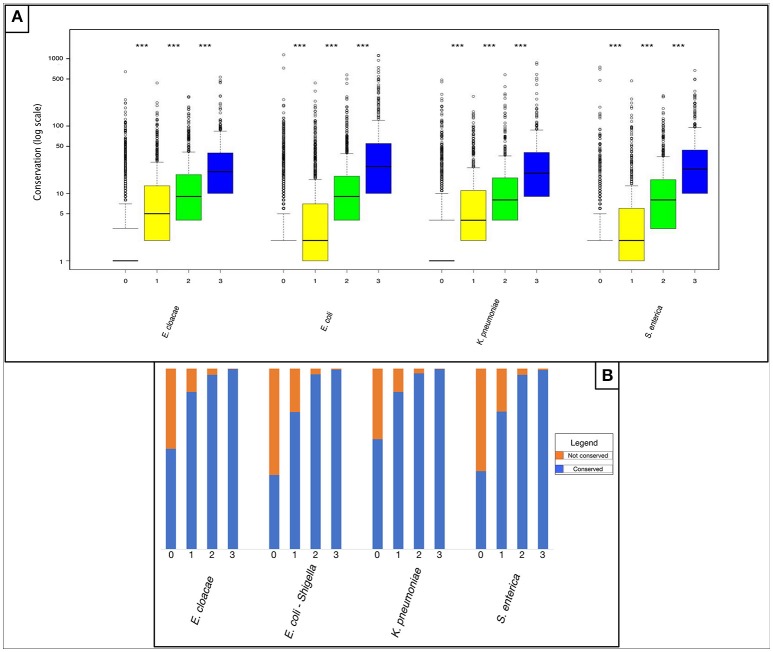
Horizontally acquired genes shared by more of the four studied Enterobacteriaceae family species tend to be more conserved in additional species as well. (A) Box plot representing the number of species in which “rare” pangenes were found, outside of the four Enterobacteriaceae family studied species. For each species four boxes are given: red – “rare” pangenes that are not shared in any of the three other species; yellow—“rare” pangenes shared by one additional species; green—“rare” pangenes shared by two additional species; blue—“rare” pangenes shared by all species. Whisker length for each boxplot represents 1.5 IQR. Statistical significance of differences between the gene-loss groups according to a non-paired, one-sided Mann-Whitney-Wilcoxon test is denoted by: ***P ≤ 0.001. The Y-axis is presented in logarithmic scale. (B) Bar plot depicting the percent of “rare” pangenes in each sharing group that are not conserved outside the four analyzed species (orange), or that are shared outside the four analyzed species (blue).